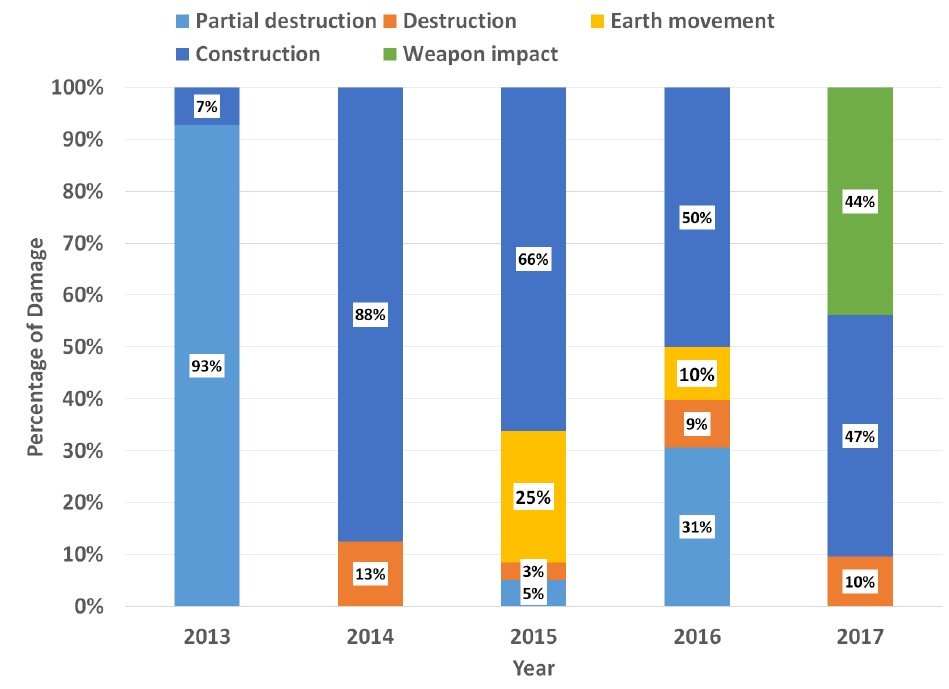
Figure 13. Percentage of damage by type observed respect to the total (100%) over the entire period (November 2013–March